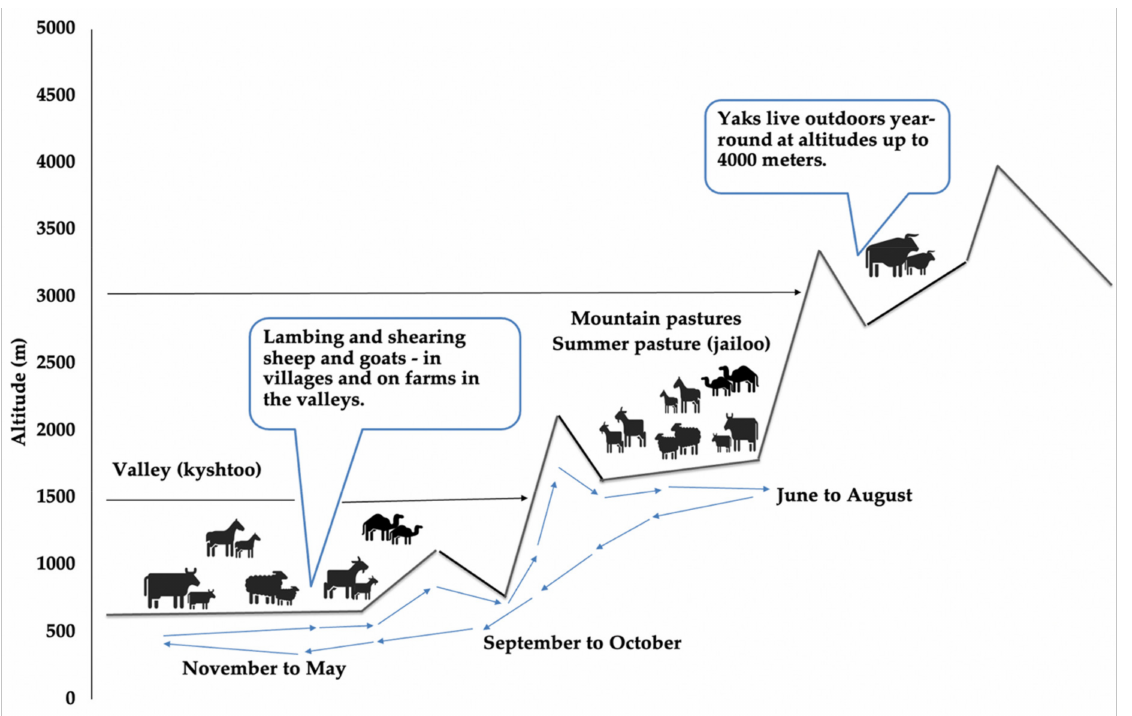
Figure 1. Transhumance seasonal movement of livestock in Kyrgyzstan. Adapted from Van Veen (1995) [12].